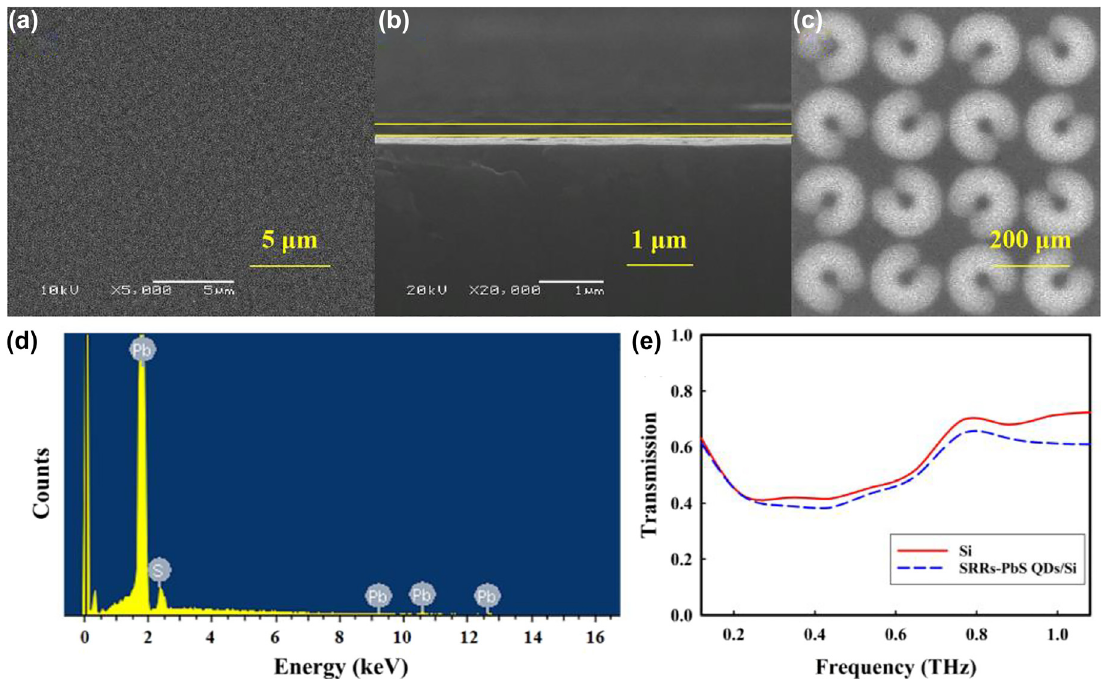
Figure 1: SEM photographs of surface morphology. (a) cross section (b) of the PbS QDs fi lm and (c) the SRRs structure. (d) The EDS spectra detected from an area of the PbS QDs fi lm. (e) The transmission of our device.